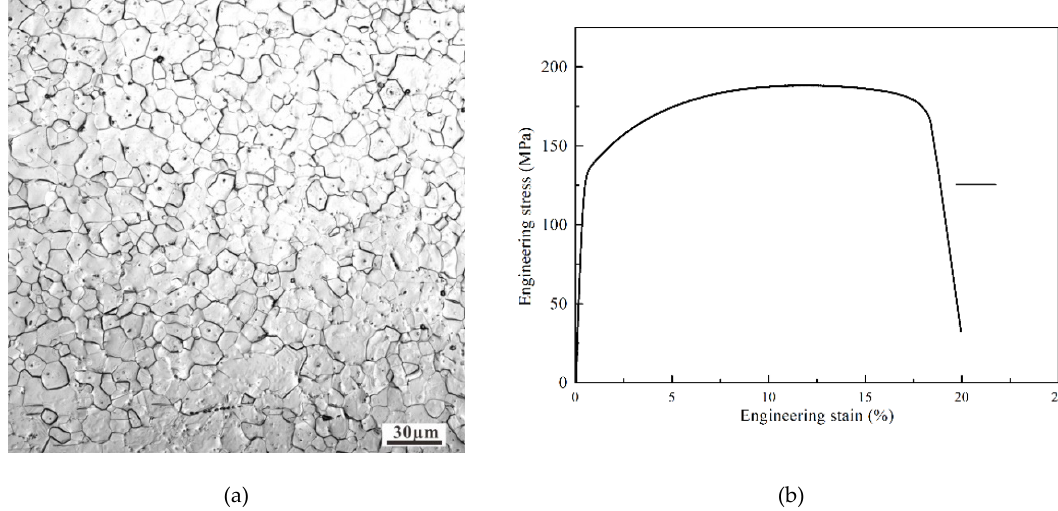
Figure 1. ( a ) OM image showing the microstructure of the initial pure Mg material ( b ) engineering stress of the pure magnesium.